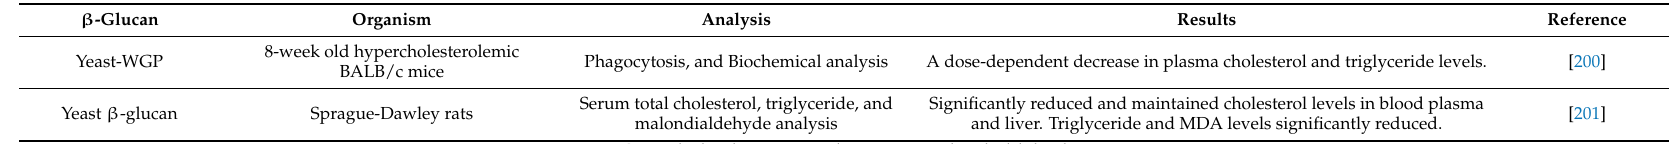
Table 13. Cholesterol and blood lowering effects of β -glucans—animal study.